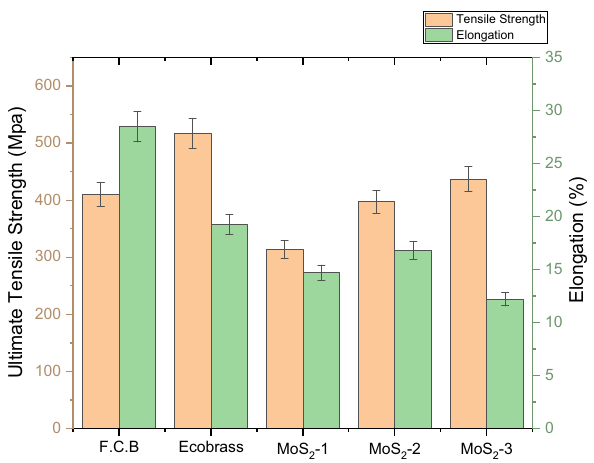
Figure 12: Comparison of the ultimate tensile strength and elonga - tion of the